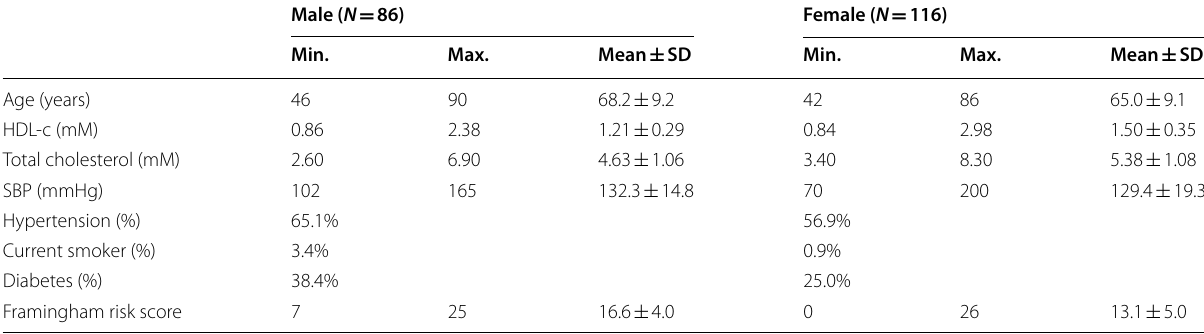
Table 1 Demographic and baseline characteristics of subjects